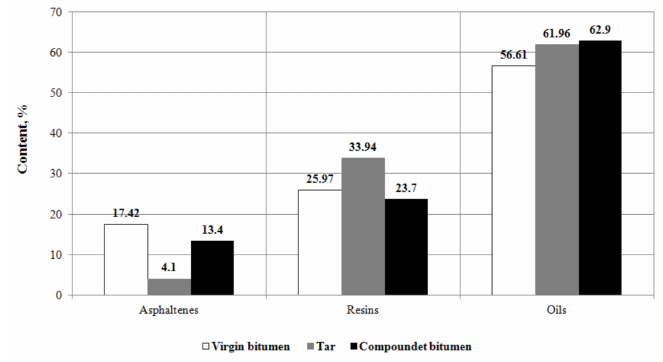
Figure 8. Group chemical compositions of the bitumens.